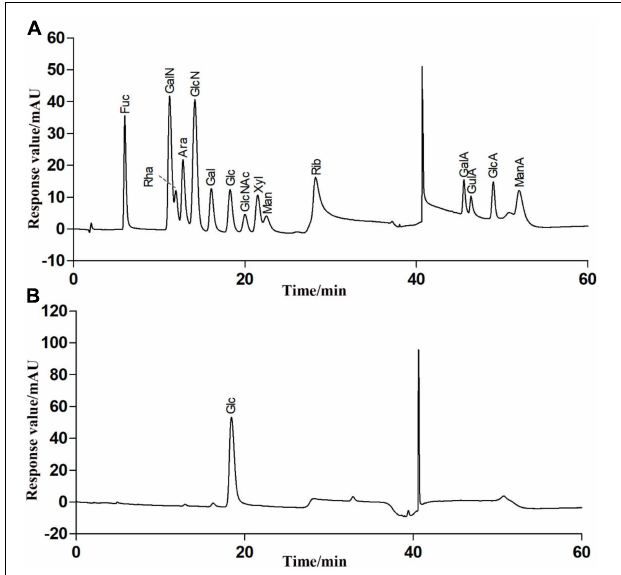
FIGURE 3 | High-performance anion exchange chromatogram of the fifteen mixed standard monosaccharaides (A) and purified polysaccharide RATAPW (B) .